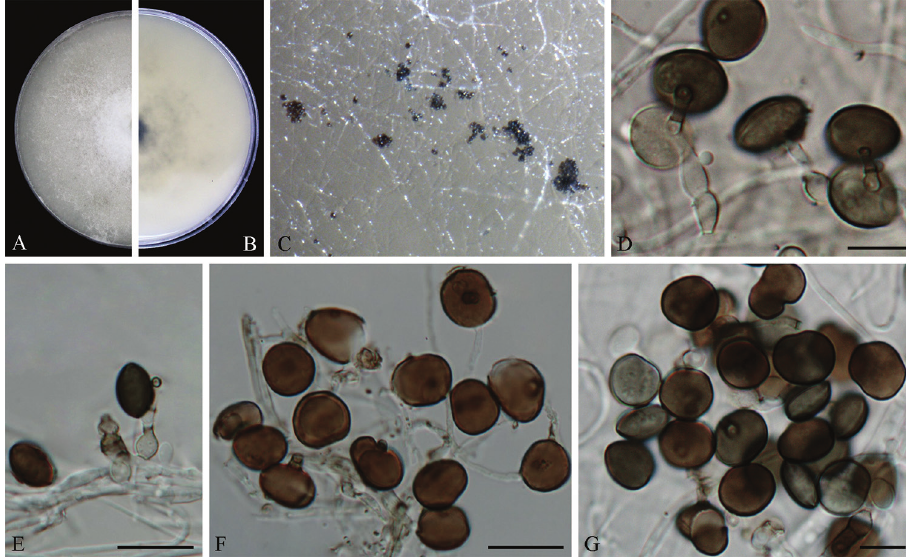
Figure 3. Arthrinium bambusae (from ex-holotype strain CGMCC 3.18335) A–B 7 d old cultures on PDA C Colony on MEA producing conidia masses D–F Conidiogenous cells giving rise to conidia G Conidia. Scale bars = 10